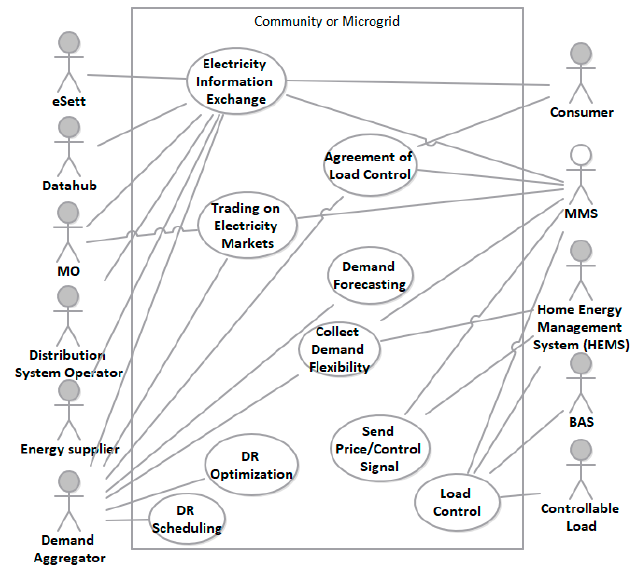
Figure 10. Use case diagram of the demand response for ancillary services PUCs.